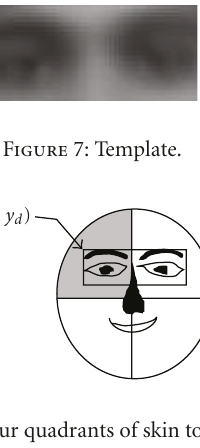
Figure 8: Four quadrants of skin tone regions.